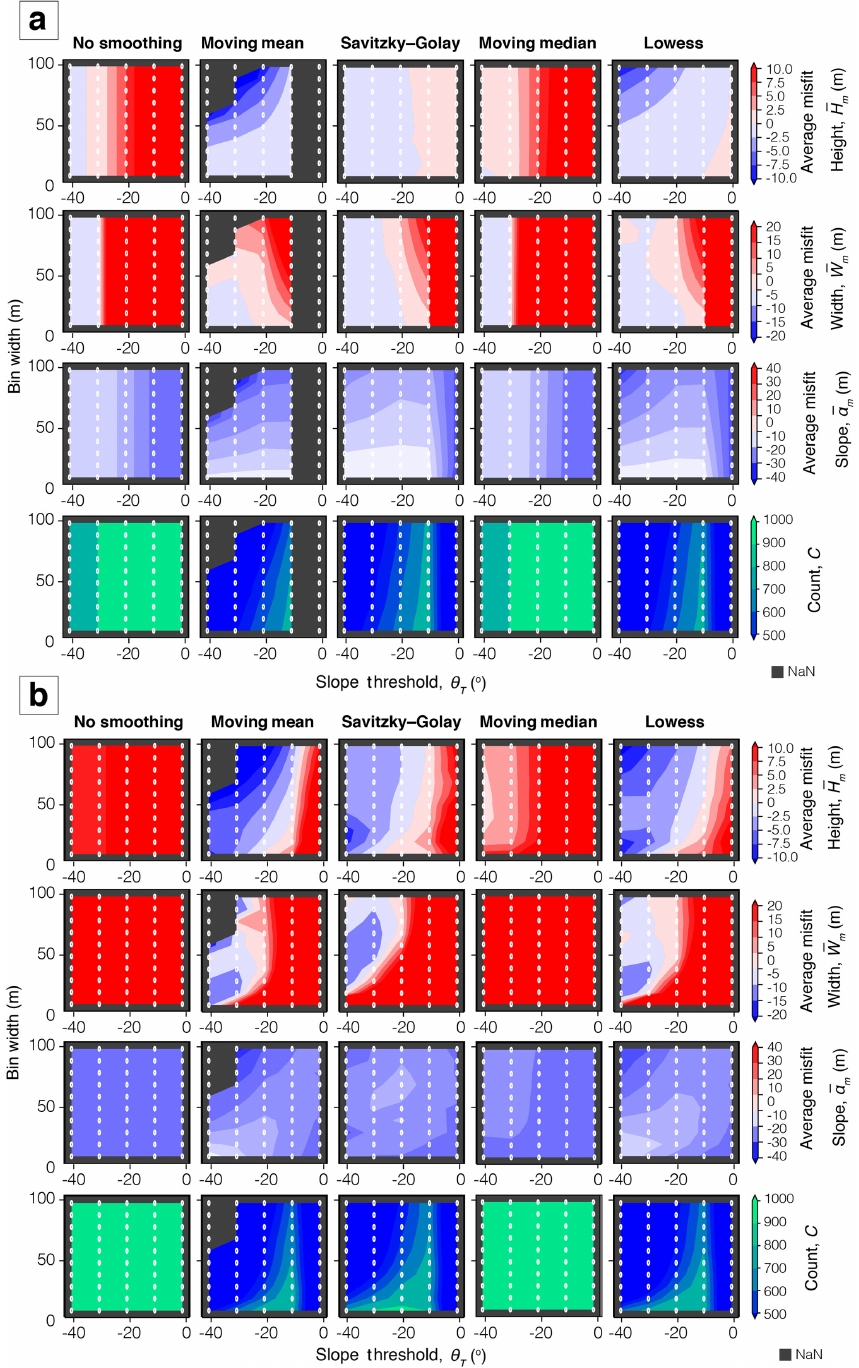
Figure 5. The average misfit and count for 1000 (a) noise-free and (b) noisy synthetic catalogue fault scarps, where by “noise” we refer to non-tectonic topographic features leading to ambiguity in the DEM. Grey values denote no fault scarp was identified for all profiles. For resolutions of 5, 10 and 30m, see the